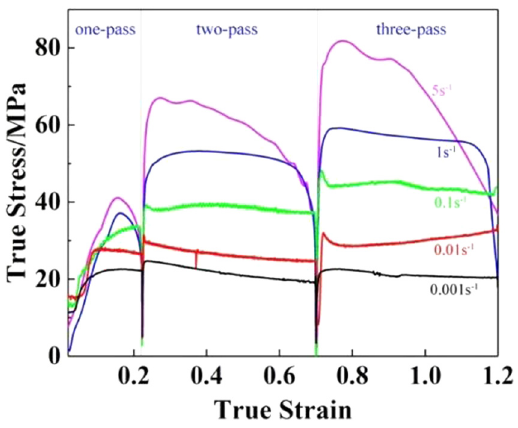
Figure 3: Average of the relative density of each pass and the microstructures of the TC4 titanium